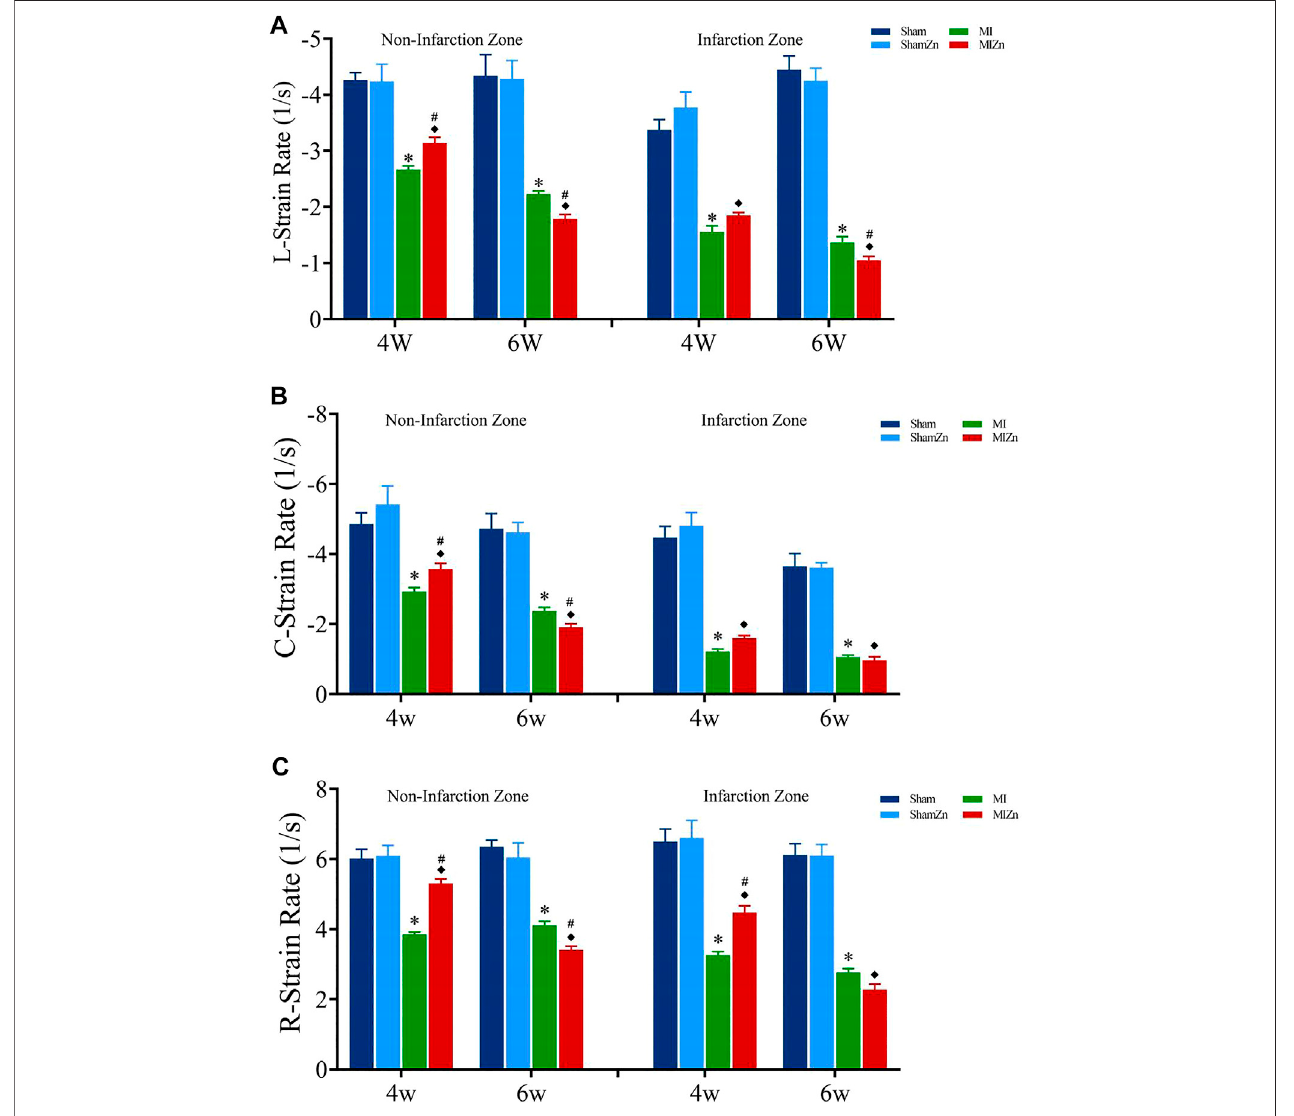
FIGURE3| Strainratepeakvaluesinthelongitudinal (A) ,circumferential (B) andradial (C) directionsofmyocardialinfarctionzoneandnon-infarctionzoneineightgroups,L: Longitudinal, C: Circumferential, R: Radial. All of the data were shown as Mean ± SEM. * p < 0.05, MI vs. Sham; ◆ p < 0.05, ShamZn vs. MIZn; # p < 0.05, MIZn vs. MI.